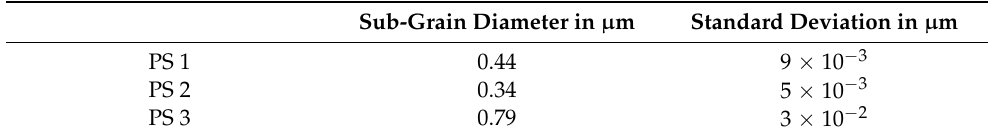
Figure 6. CBS Image taken at a HFW of 25 µm, HV = 10 keV, I = 2.8 nA ( a ) PS 1, ( b ) PS 2, ( c ) PS 3 in the xy plane.